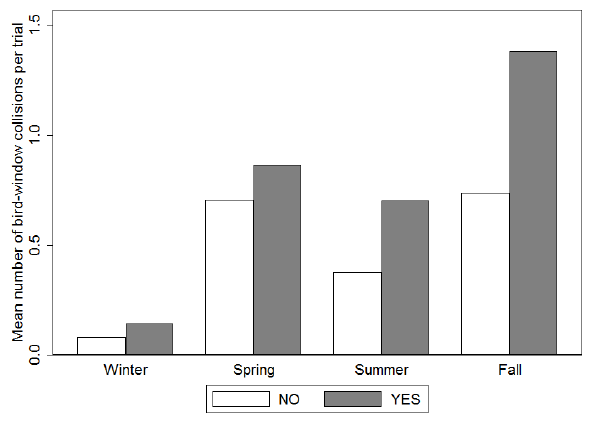
Fig. 2 . Bar graph showing the mean number of bird-window collisions for each season: winter (n = 92), spring migration (n = 39), summer breeding (n = 40), and fall migration (n = 40). The mean number of collisions was calculated for each season and subdivided for trials with no bird feeder (NO) and trials with a bird feeder present